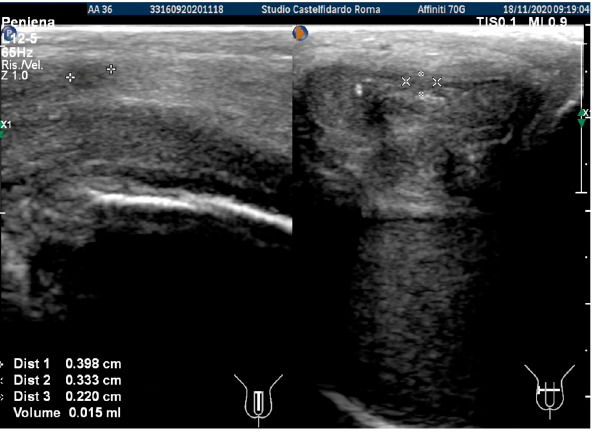
Figure 3. Ultrasonography of the penis after the 2nd therapy cycle (longitudinal and axial views).